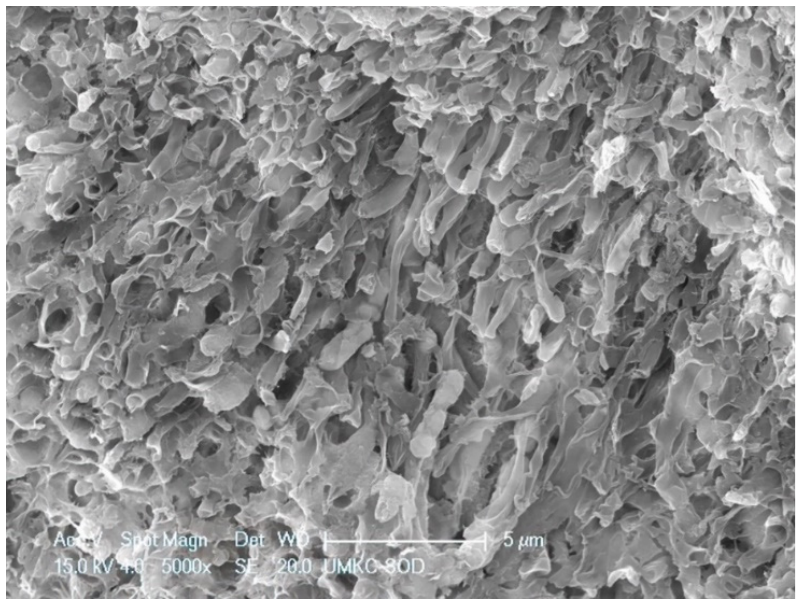
Figure 7. SRP + EDTA-treated specimen. High magnification view of a cluster of rod-shaped microbes showing loss of EPM, rupture of terminal ends of many of the microbes, and general loss of distinctive morphology. Original magnification of 5000×; Bar = 5 μ m.